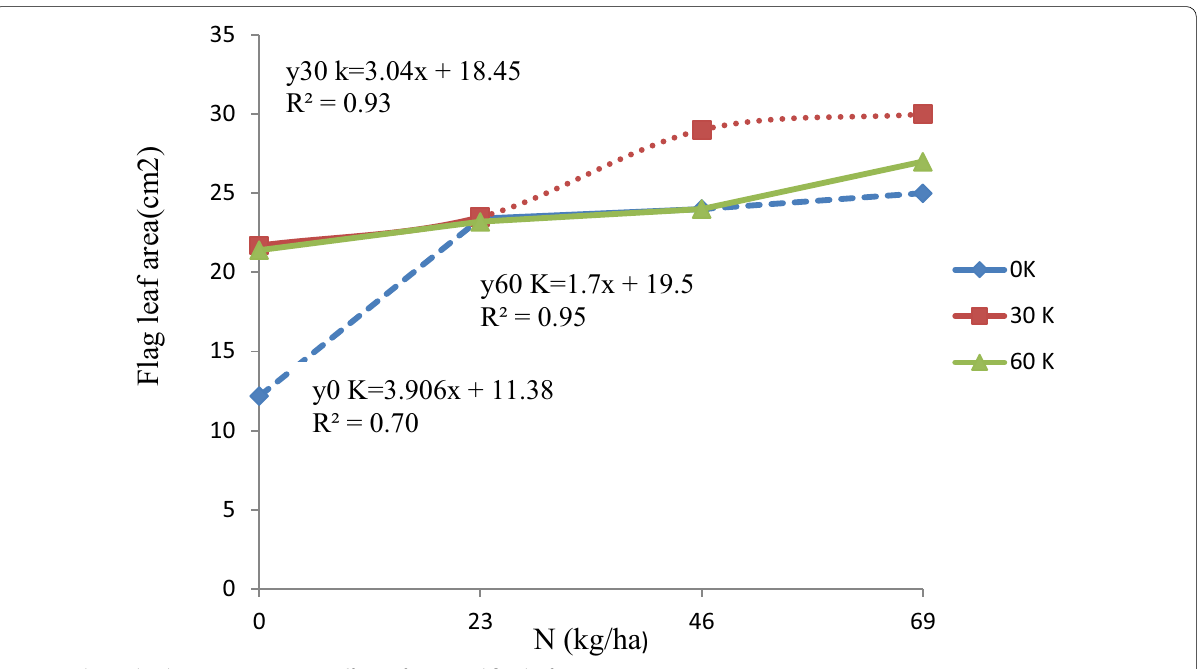
Fig. 2 Relationship between interaction effects of N x K and flag leaf